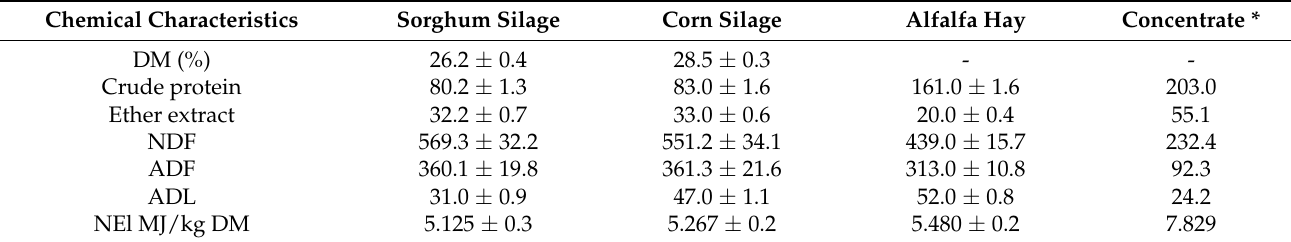
Table 2. Feeds chemical composition (g/kg DM) and nutritive value.